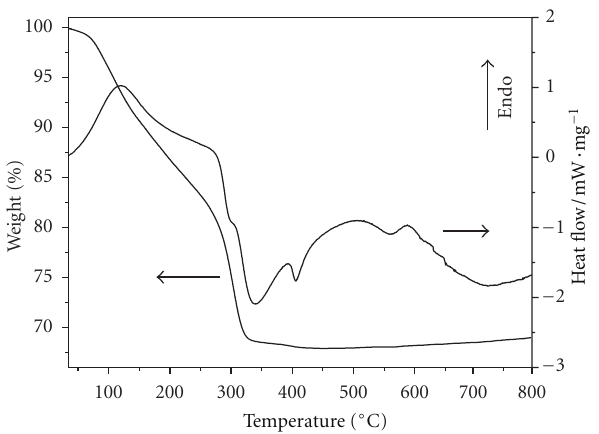
Figure 3: TG-DSC curves of a precursor.